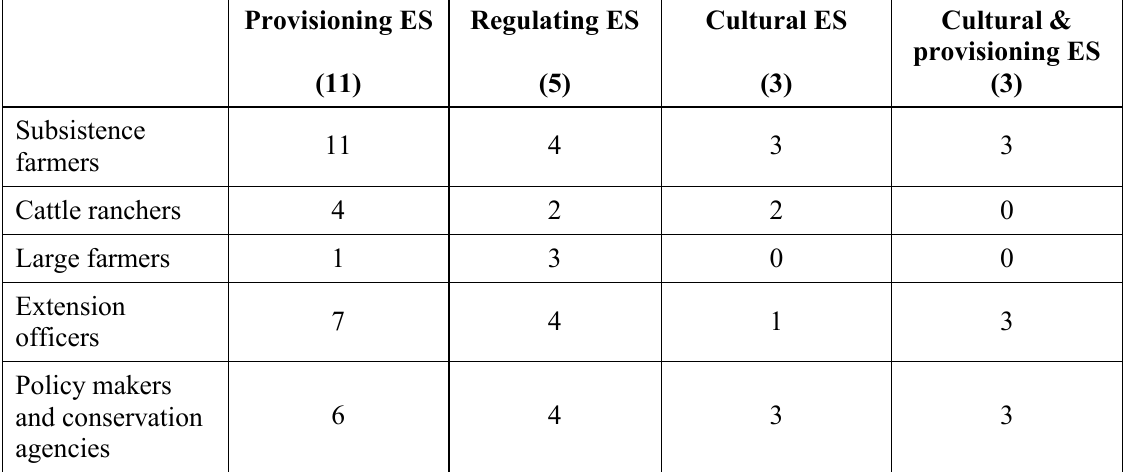
Table 2: Number of different types of ecosystem services (ES) as perceived by different Table social actors (SA). The number between brackets indicates the total number of ES in each category identified by all SA.